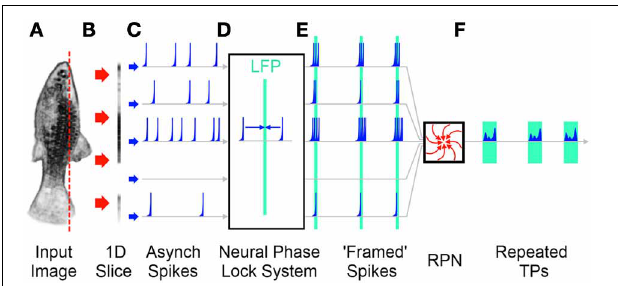
FIGURE 11 | A simplified illustration of a decentralized frame producing system without a sample and hold operation. (A) A 2D image is projected onto the retina. (B) A 1D slice of the retina is illustrated. (C) The sensors on the retina produce spikes in an asynchronous, stochastic fashion. Each spike channel represents the path of a single “pixel” from the 2D retina through the visual system. (D) The asynchronous activations travel through a neural phase lock mechanism that bunches temporal patterns into frame like wave fronts of activity around Local Field Potentials (LFPs) (Martinez, 2005). (E) The resulting image “frames” are projected on to the RPN as described earlier. (F) The resulting output TPs are generated for recognition by the memory system. Note the unequal inter-frame times that would be produced due to the unclocked nature of a biological